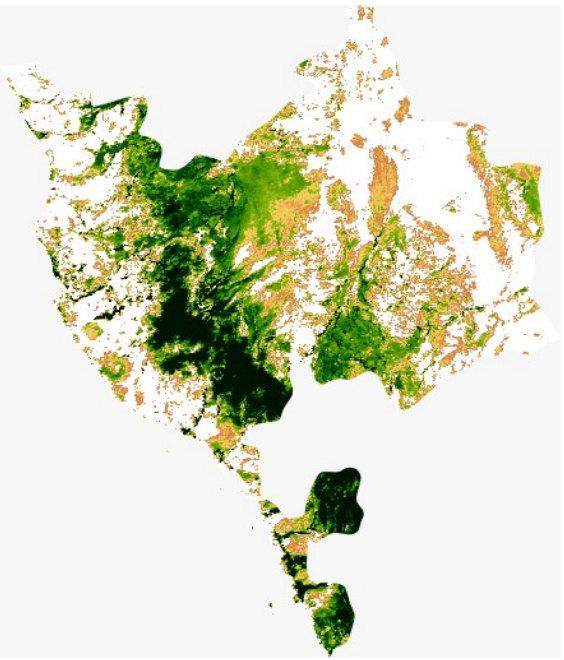
Figure 1. Map of Makkah province demonstrating the study area, obtained from MODIS satellite Image Collection via Google Earth using bespoke python code.